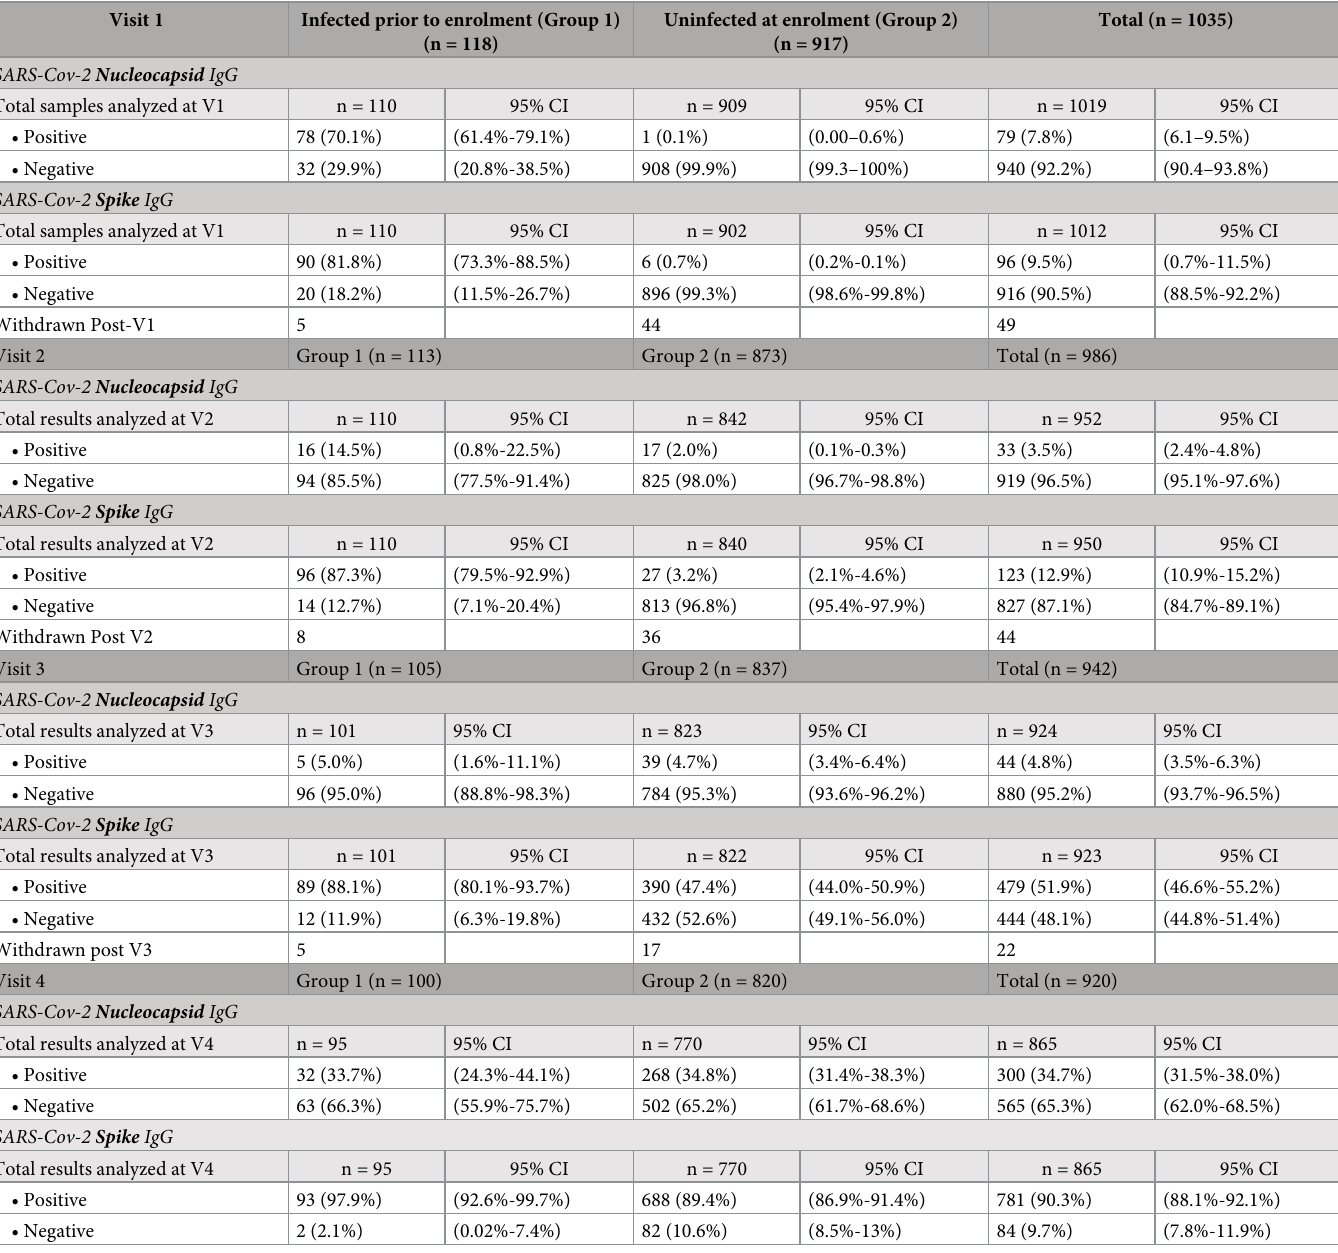
Table 3. Serology results from Visits 1–4 for participants infected prior to enrolment (Group 1) and not infected at enrolment (Group